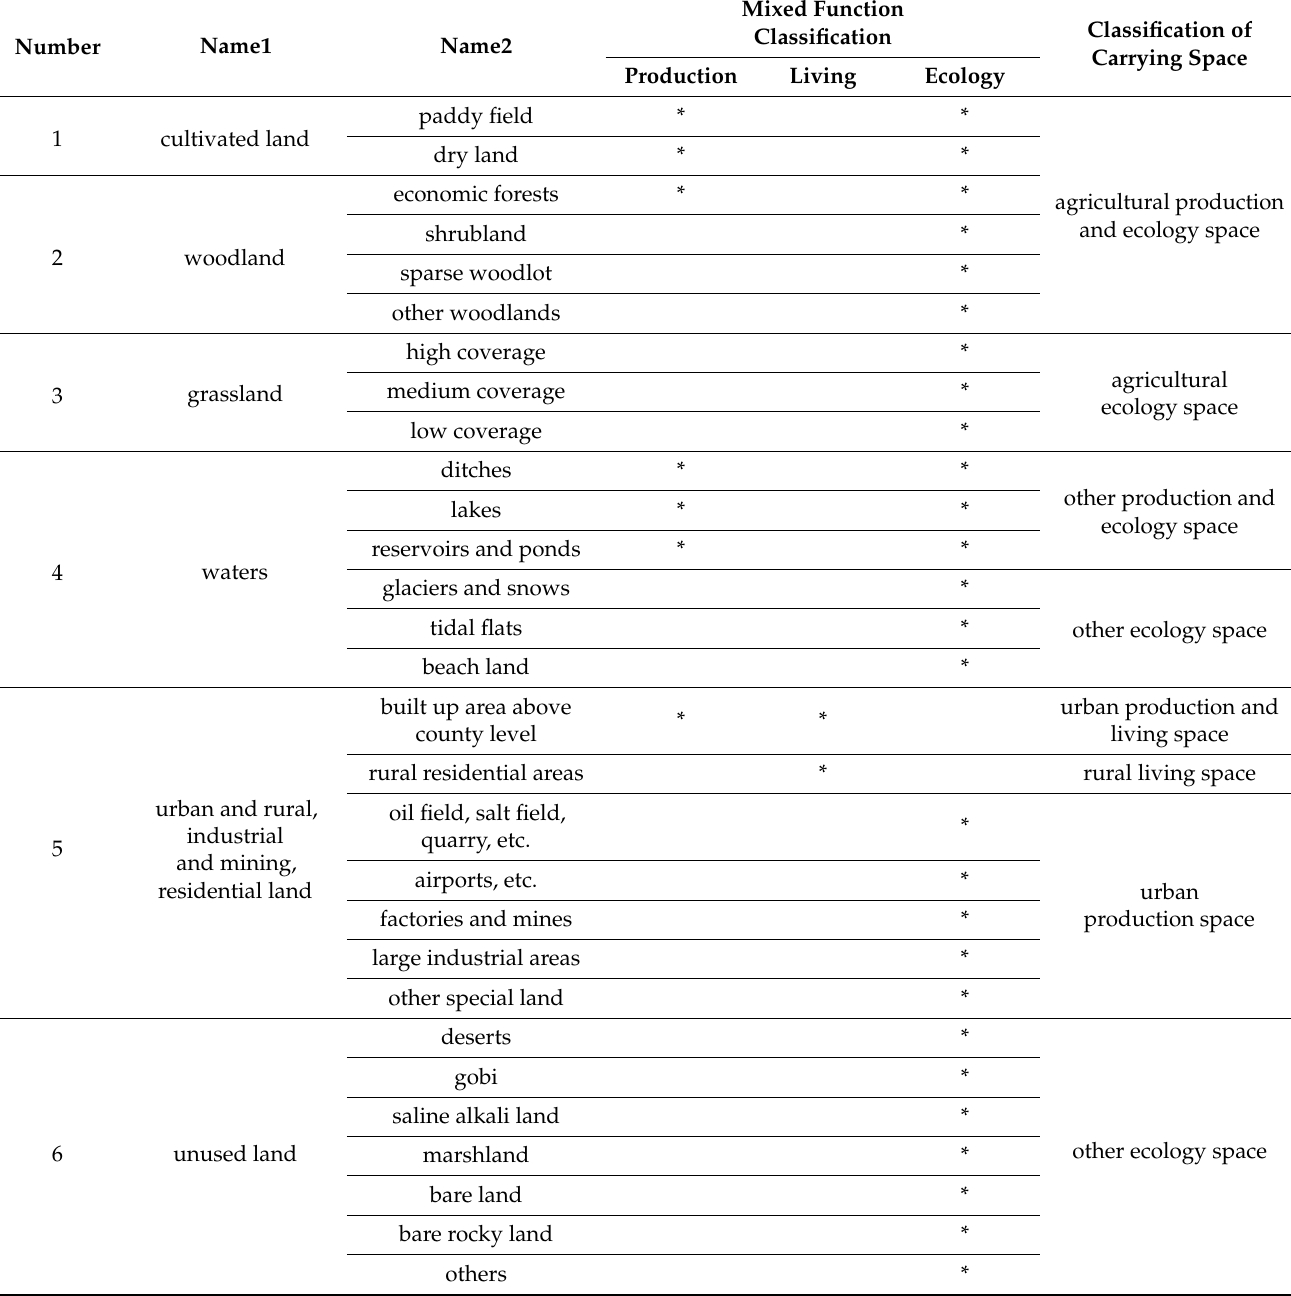
Table 1. Division of urban mixed function space based on “production, living and